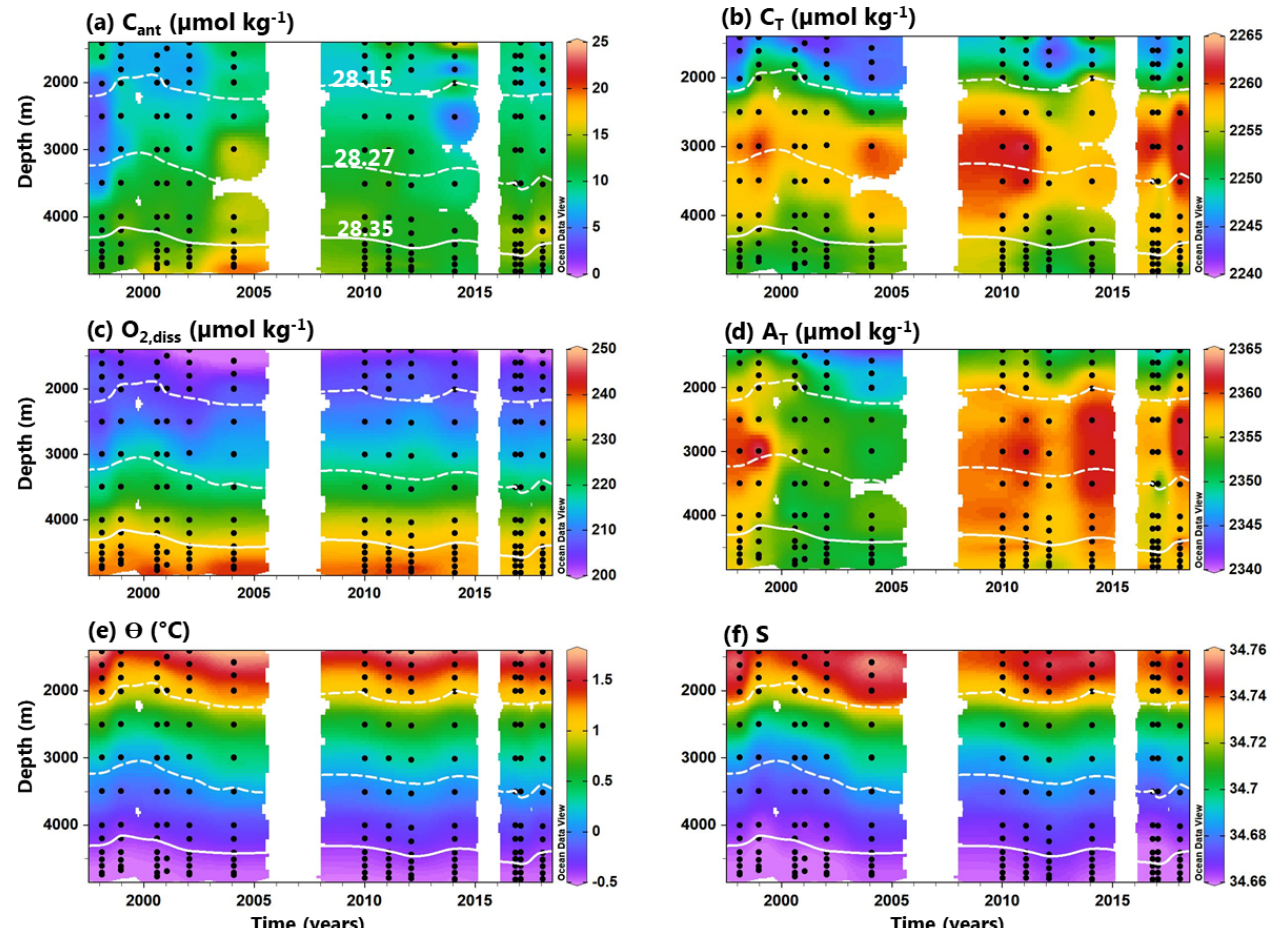
Figure 2. Hovmöller diagram of (a) C ant via TrOCA, (b) C T , (c) O 2 , (d) A T , (e) (cid:50) and (f) S based on the OISO data presented in Table 1. Data points are represented by black dots. The white isolines represent the water mass separation by γ n (from the bottom: LAABW, UAABW and LCDW). Figure produced with Ocean Data View (Schlitzer,